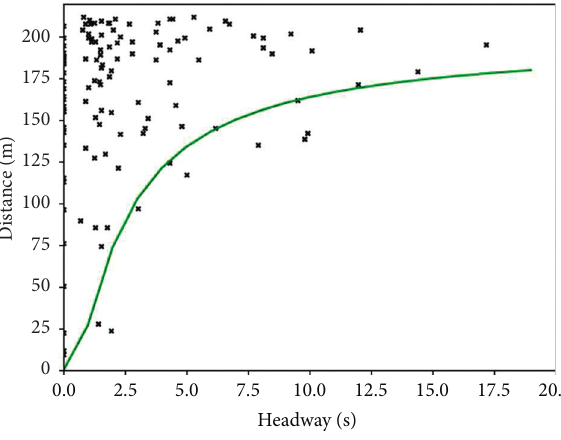
Figure 8: Headway of lane changing.